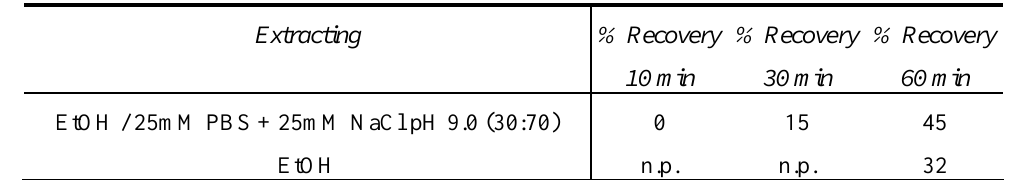
Table 2. % recovery of the extraction of AT with ultrasounds bath with different solvents and times calculated trough UV spectroscopy.